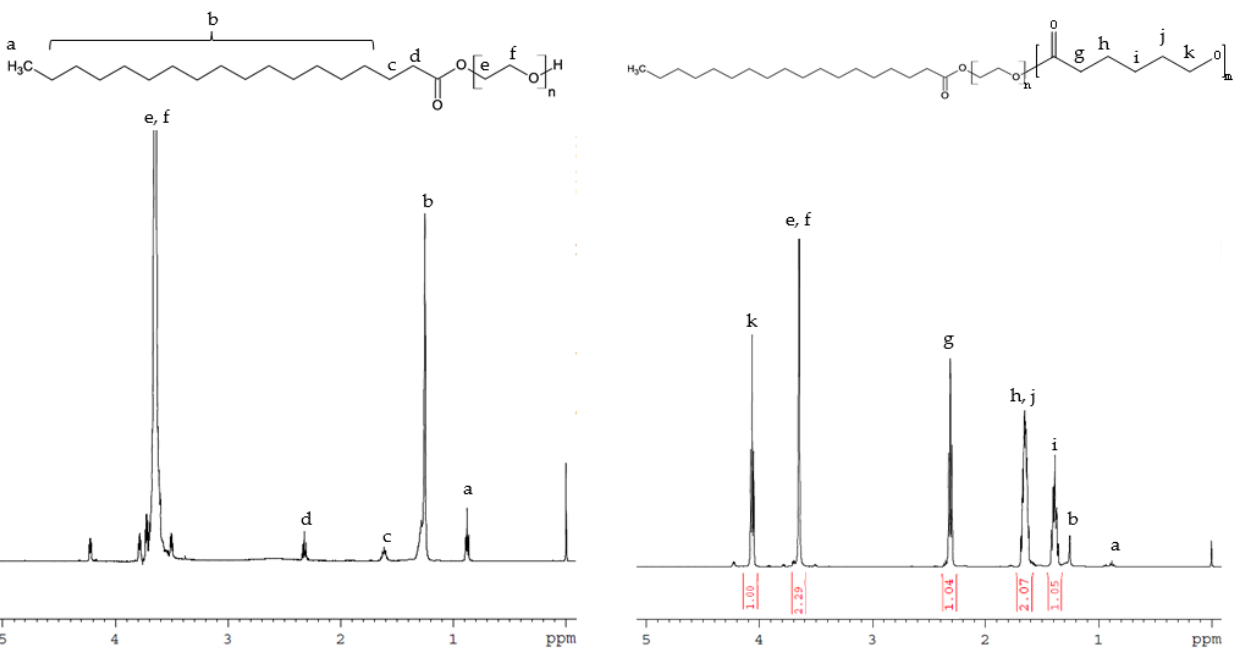
Figure 2. Representative 1 H NMR spectra of Myrj S100 ( left ) and Myrj S100- b -PCL 88 ( right